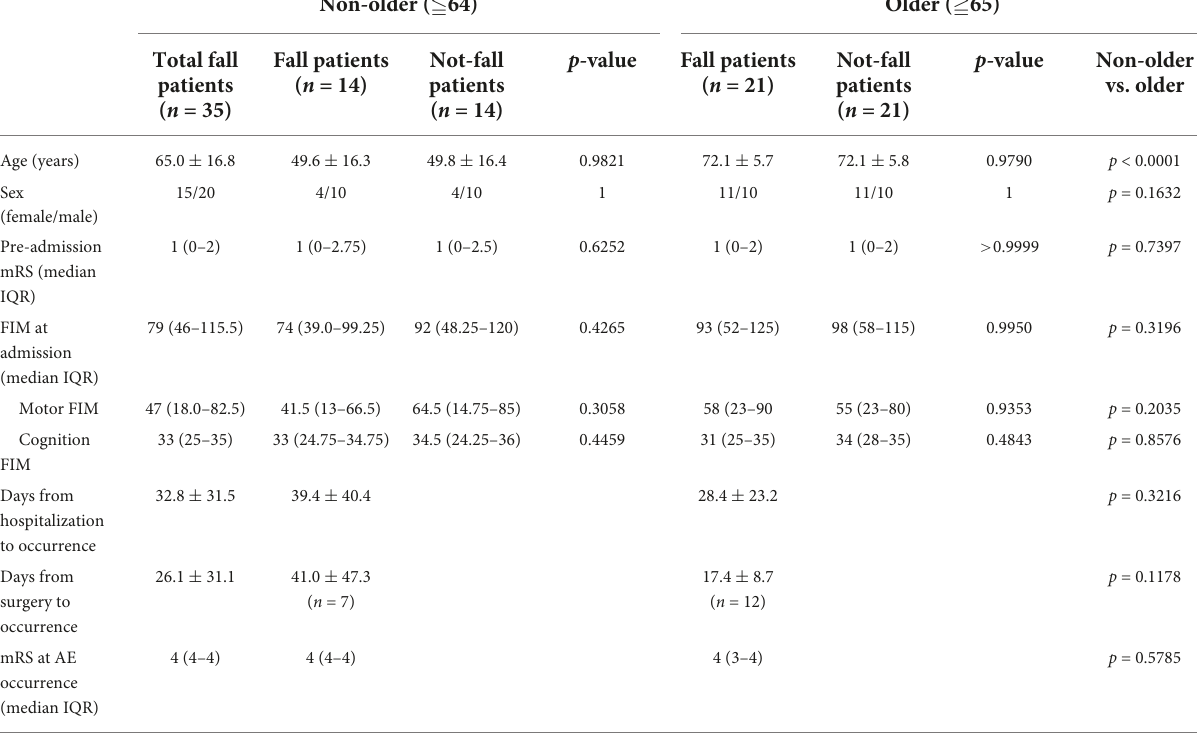
TABLE 2 Characteristics of non-older and older adults who fell during